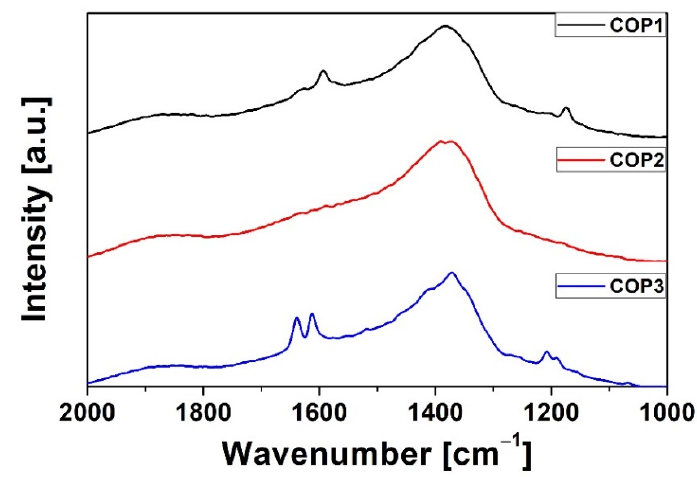
Figure 2. Raman of styrylquinoline copolymers.